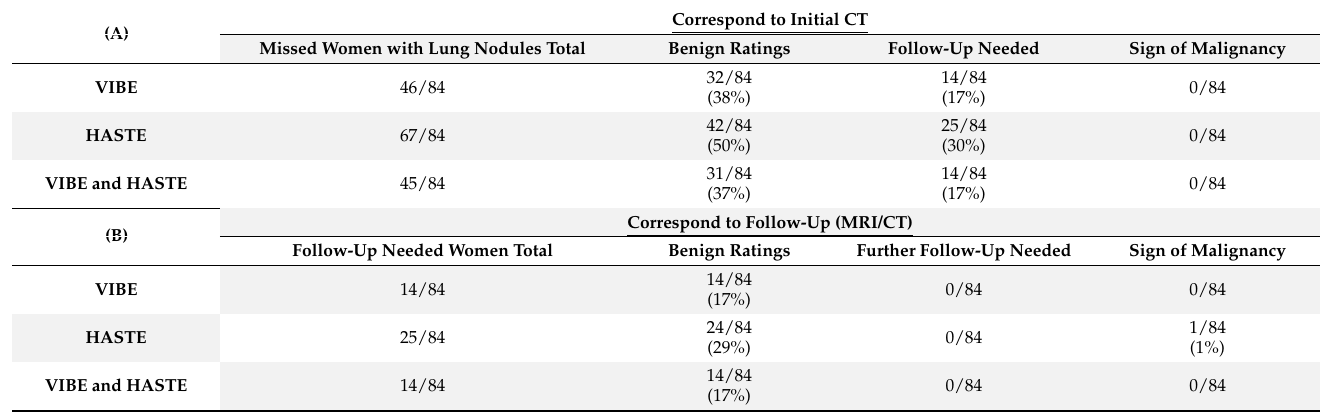
Table 1. Patient-based analysis. ( A ) Classification of women with missed lung nodules at MRI VIBE, MRI HASTE and MRI VIBE and HASTE based on initial CT. ( B ) Classification of women with missed lung nodules at MRI VIBE, MRI HASTE and MRI VIBE and HASTE based on initial CT that needed further follow-up imaging.